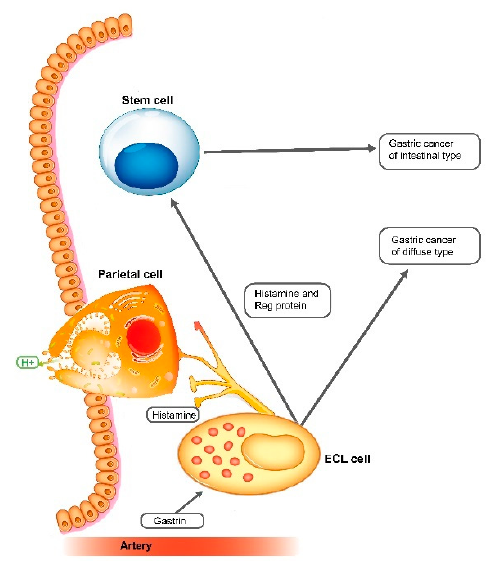
Figure 1. The central role of gastrin and the enterochromaffin-like (ECL) cell in the regulation of gastric acid secretion and in gastric carcinogenesis (reproduced by permission from the publisher, reference 139).